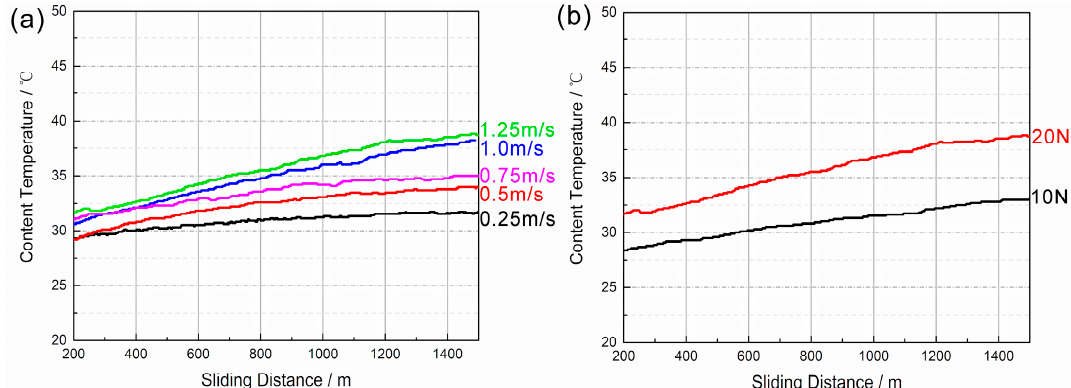
Figure 6. Contact temperature versus sliding distance for ( a ) normal load of 20 N and ( b ) sliding speed of 1.25 m/s.